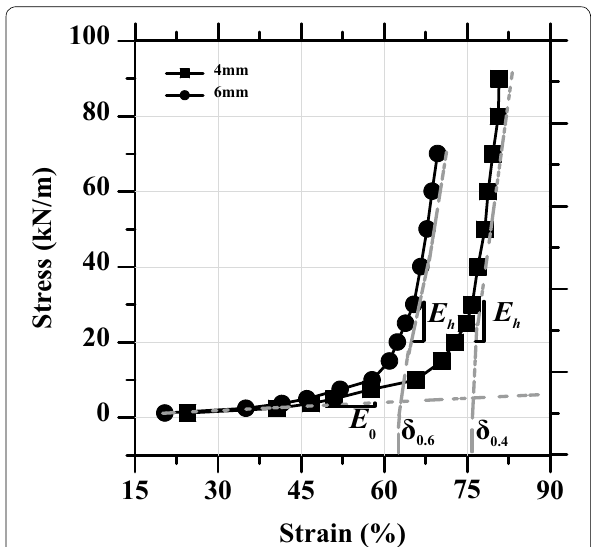
Fig. 11 Bilinear model for the experimental results of the compression tests.